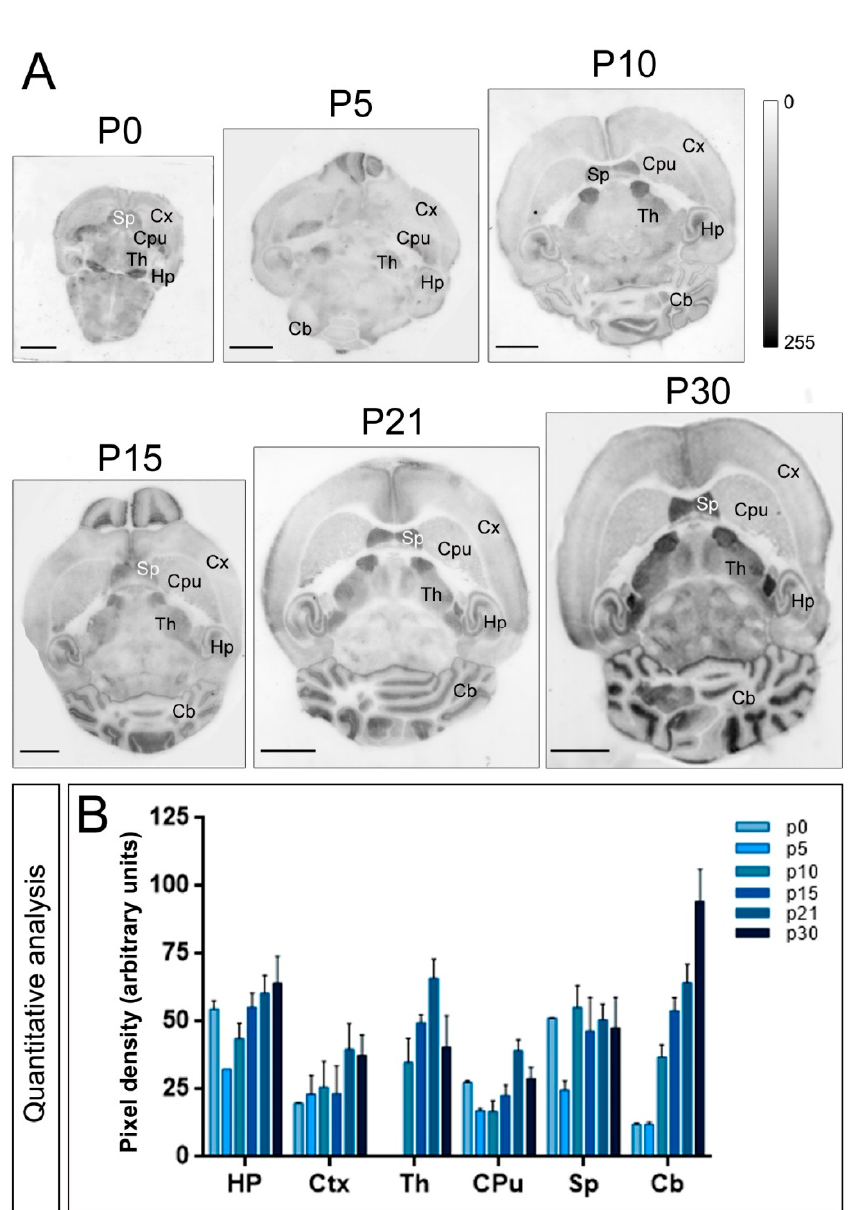
Figure 4. Developmental and regional distribution of the Kv4.3 channel in the mouse brain . ( A ) Kv4.3 protein distribution was visualised on histoblots of brain horizontal sections at various stages of postnatal development using an affinity-purified anti-Kv4.3 antibody. Kv4.3 was expressed in the brain since the day of birth (P0), and at all stages the strongest expression was detected in the cerebellum (Cb), thalamus (Th), hippocampus (Hp) and septum (Sp), with the lowest intensity in the caudate putamen (CPu) and cortex (Cx); ( B ) The histoblots were scanned and densitometric measurements from four independent experiments were averaged to compare the protein densities for each developmental time point. The analysis revealed a differential Kv4.3 expression in a region- and developmental-dependent manner. Kv4.3 expression was detected at P0, thought at some time points was not possible to quantify. Then, expression increased progressively to reach a peak at P10, P15 or P21 depending on the brain region, and then decreasing at P30 in cortex, thalamus, caudate putamen and septum, or increasing until P30 in hippocampus and cerebellum. Error bars indicate SEM. Scale bars, 2 mm.